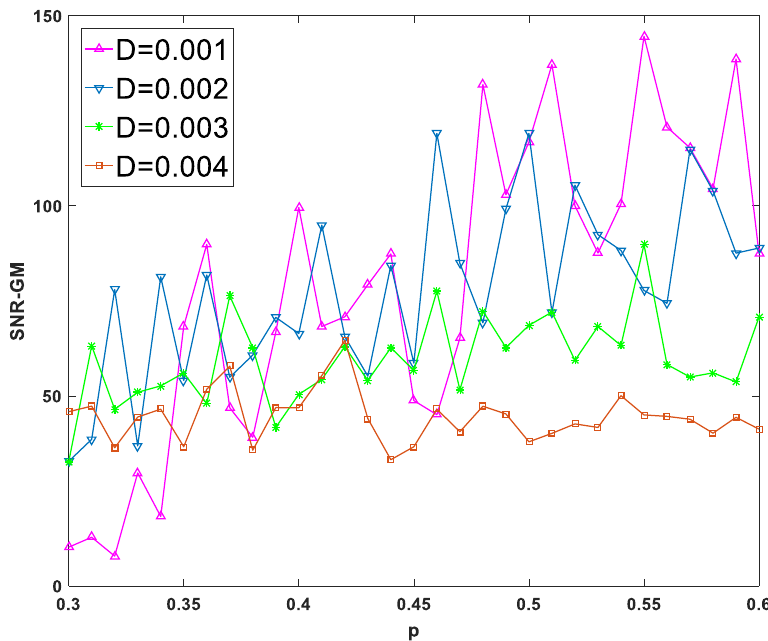
Figure 6. SNR-GM varies with m for different values of D ( m = 2.0, q = 1.2).